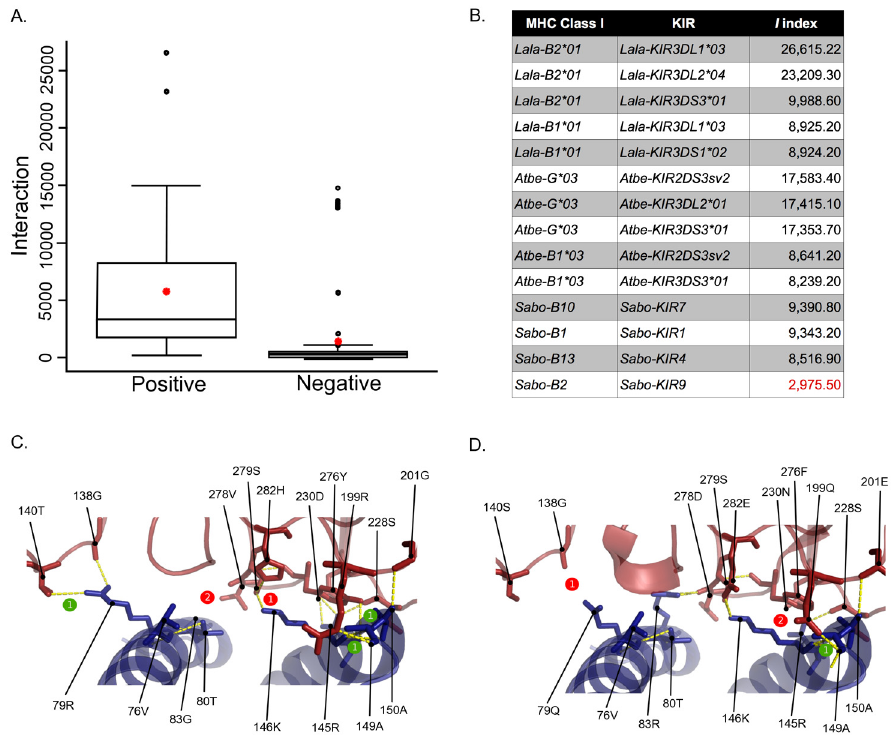
Fig 7. Interaction ( I ) index proposed to predict stable interaction between MHC class I and KIR molecules, based on the number of hydrogen bonds and the desolvation energy. A, Box plot of I index values from experimentally validated human, chimpanzee and Rhesus monkey MHC:KIR pairs with functional interactions (positive, n = 45) and lack of interaction (negative, n = 71). The red star indicates the average I index value for positive and negative interactions. B, I index values derived from models of Platyrrhini MHC:KIR interacting pairs. Structural model of interacting pairs Lala-B2 * 01:Lala-KIR3DL1 * 03 with I = 26,615 (C) and Sabo-B2:Sabo-KIR9 I = 2,975 (D). Number of hydrogen bond gained (numbers in green circles) and lost (numbers in red circles) with respect to the human HLA-B * 5701:KIR3DL1 (PDB: 3VH8) interaction are indicated along with the MHC class I and KIR residues critical for the interaction [29]. Accession numbers for the Platyrrhini KIR sequences used in this analysis are in the S3